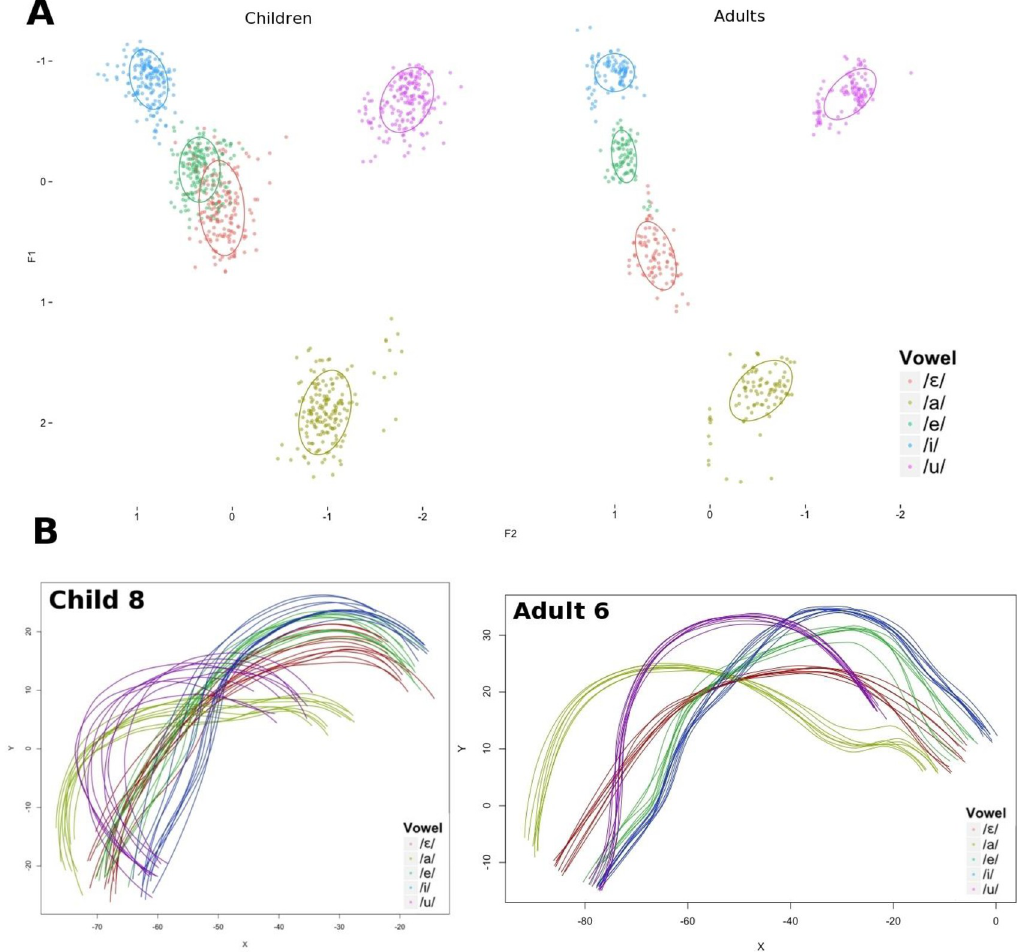
Fig 3. Illustration of the trial-to-trial variability in vowel production in the acoustic and articulatory domains, and the main differences between the group of adults and the group of children. Top panels: Variability in the z-scored (F1, F2) planes for the group of children (left) and the group of adults (right). Bottom panels: Examples of articulatory variability in the mid-sagittal plane for a child (left) and an adult (right) participant; X and Y are in mm.